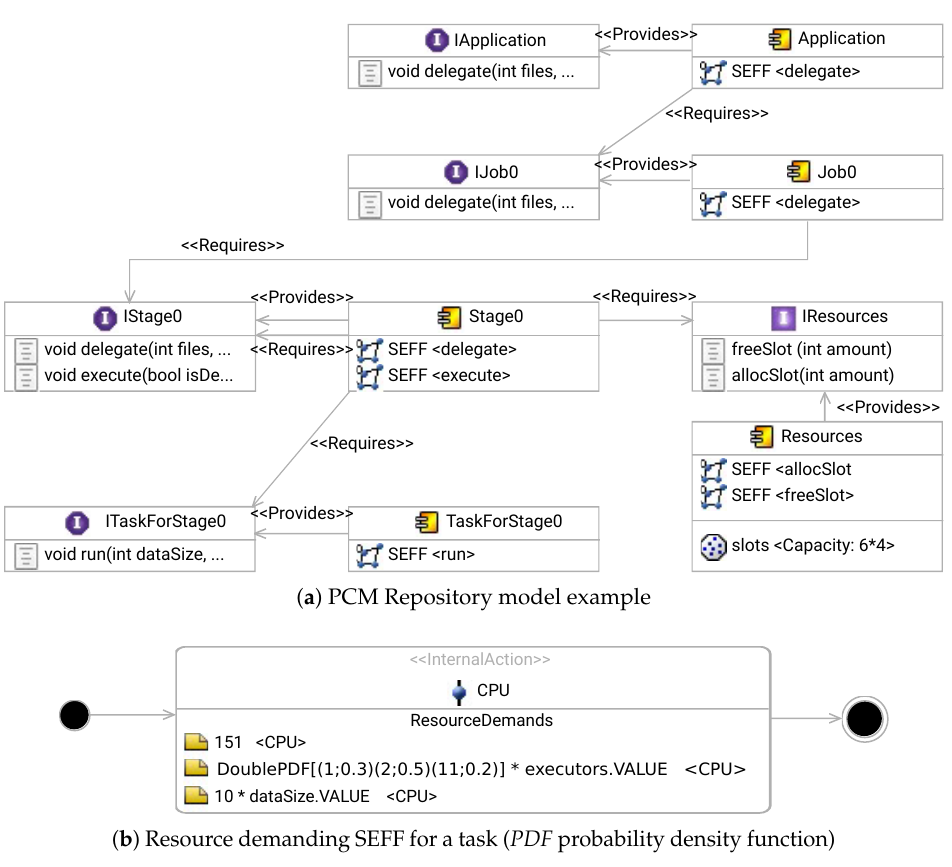
Figure 4. Exemplary transformed PCM